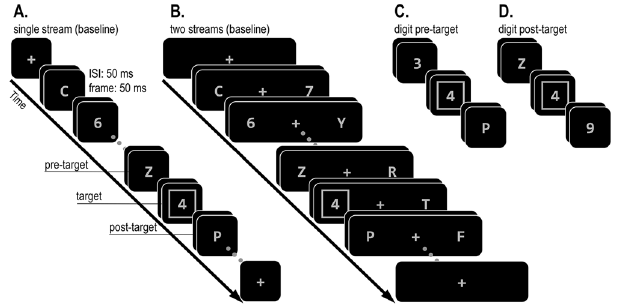
Figure 3. Illustration of the stimulus sequence in Experiment 1. Participants had to report the target digit inside a square. The target digit was embedded among streams of both letters and digits distractors such that only the square (and not its alphanumeric category) could be used to identify the target. The target appeared at positions 5 to 8 within a single ( A ) or two ( B ) streams. The pre-target frame and post-target frames contained only letters (baseline condition; A – B ) on 20% of the trials. On the rest of the trials, either the pre-target frame or the post-target frame contained a digit at the same location as the target ( C – D ).